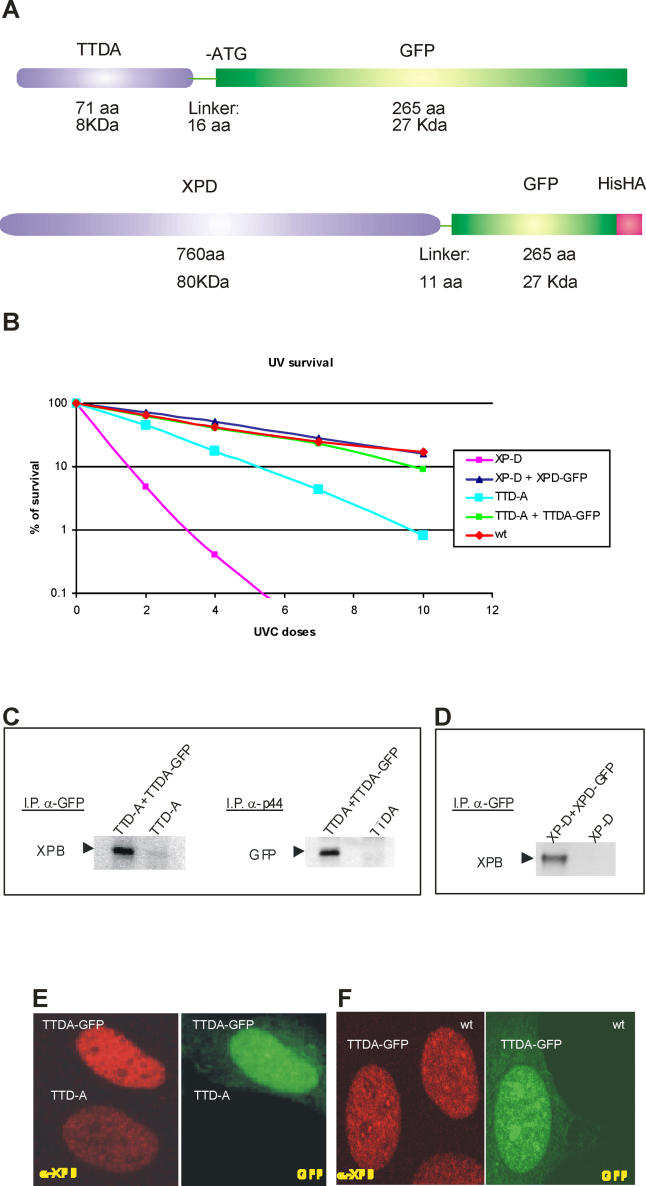
Constructs and Functionality Assays(A) Scheme of the TTD-A-GFP and XPD-GFP fusion proteins.(B) UV survival using wt VH10 cells (red diamonds), TTD1BRSV (TTD-A) cells (light blue squares), XP6BESV (XP-D) cells (pink squares), TTD1BRSV-expressing TTDA-GFP cells (green squares), and XP6BESV-expressing XPD-GFP cells (blue triangles). The percentage of surviving cells is plotted against the applied UV-C dose (J/m2).(C) Immunoprecipitation: Left panel shows that the XPB TFIIH subunit (by monoclonal anti-XPB detection) co-precipitates with anti-GFP from extracts of TTDA-GFP-expressing fibroblasts (lane 1) and not from TTD1BRSV (TTD-A) fibroblast whole-cell extracts (lane 2). Right panel shows that TTDA-GFP (detected with anti-GFP monoclonal) co-precipitates with the core TFIIH component p44 from extracts from TTDA-GFP-expressing fibroblasts (lane 1) and not in whole-cell extracts from TTD1BRSV (TTD-A) fibroblasts (lane 2).(D) Immunoprecipitation using polyclonal anti-GFP. Also the XPB TFIIH subunit co-precipitated with XPD-GFP (using anti-GFP) in extracts from XPD-GFP-expressing fibroblasts (lane 1), but not from XP6BESV (XP-D) fibroblasts (lane 2).(E) Immunofluorescence of a mixed population of TTD-A cells (label 2) and TTDA-GFP-expressing TTD-A cells. Cells expressing TTDA-GFP (right panel) showed an increased level of XPB (left panel), compared to TTD-A cells.(F) Immunofluorescence of a mixed population of VH10 (wt) cells and TTDA-GFP-expressing TTD-A cells. Cells expressing TTDA-GFP (right panel) exhibit a similar expression level of XPB (left panel) as wt cells.